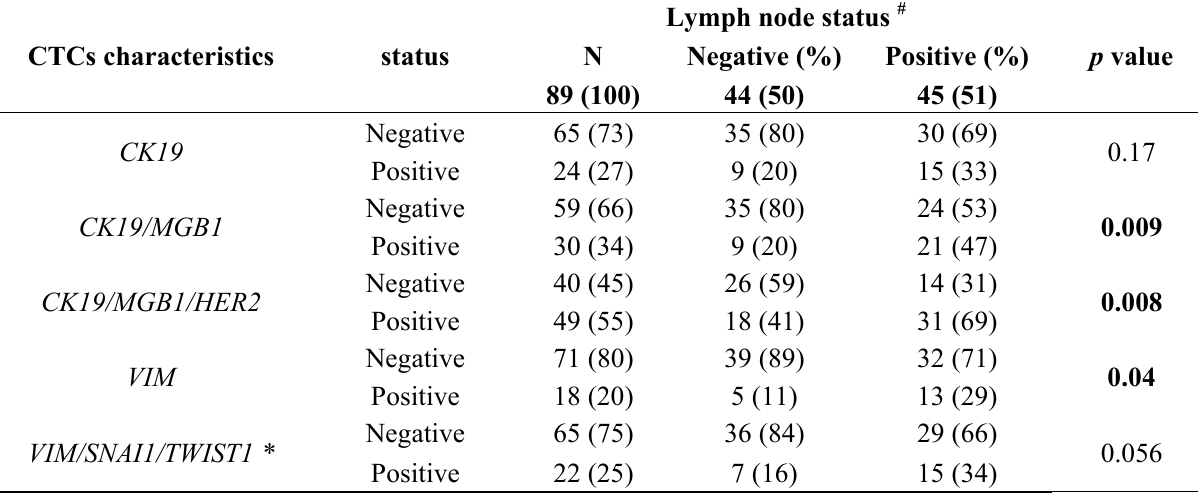
Table 2. Correlation between CTCs-EBF gene expression status (applying different phenotypes classification) and lymph node